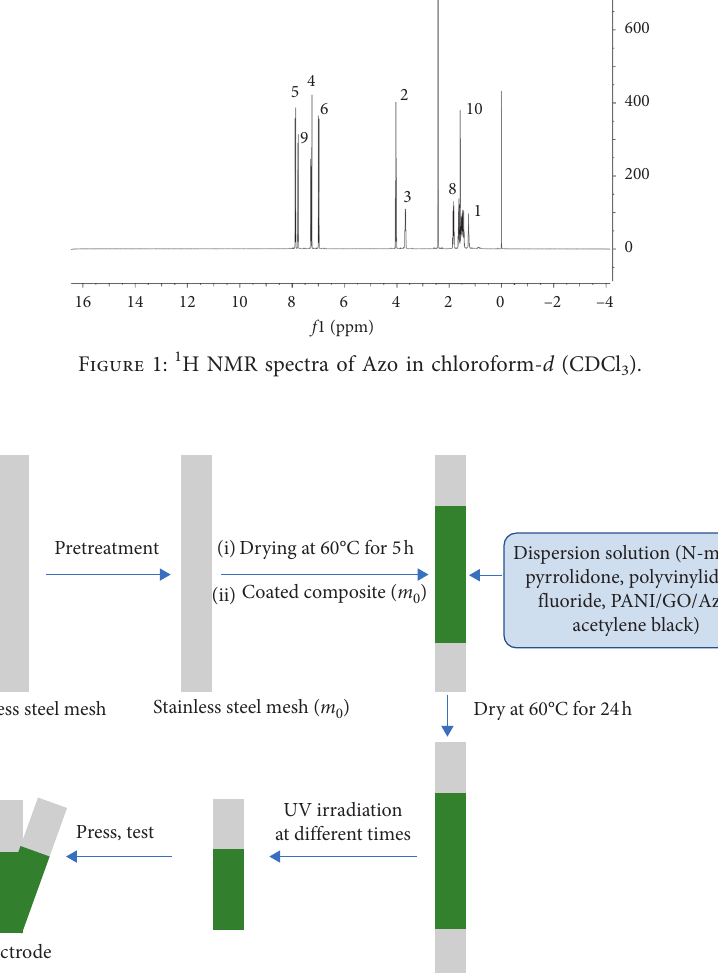
Figure 2: Illustration of the process for the preparation of the PANI/GO/Azo electrode.